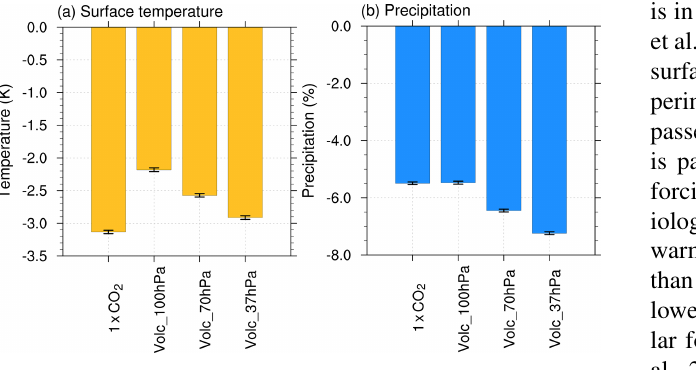
Figure 4. Changes in global and annual mean (a) surface temper- ature and (b) precipitation relative to the 2XCO2 experiment (slab ocean simulations). The error bars represent 2 standard errors cal- culated from 60 annual means of the difference from the 2XCO2